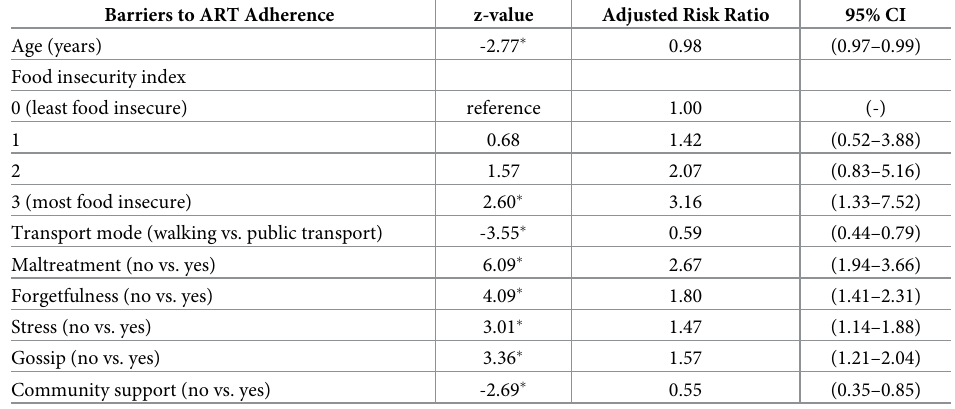
Table 3. Results of multivariable analysis of barriers associated with nonadherence to ART among WLHIV in rural communities of